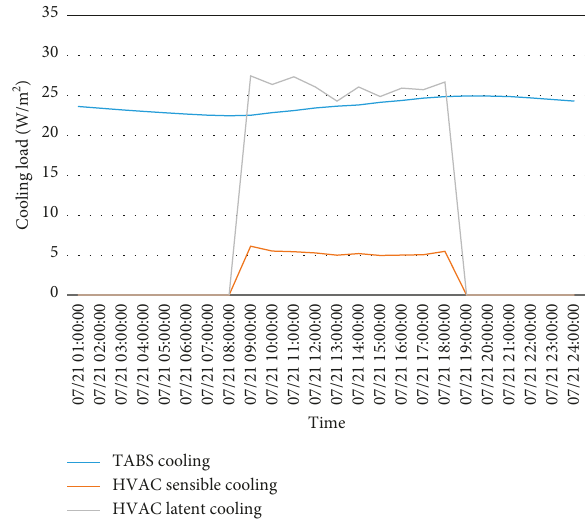
Figure 17: Amount of TABS and DOAS cooling in the lecture